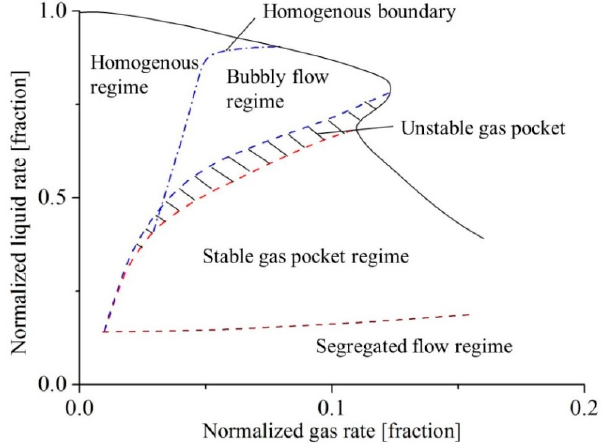
Figure 1. Example of two-phase mapping proposed by Estevam et al. [17] and Barrios [18] for ESP pumps. Pump head coefficient ratio ψ * tp = ψ tp / ψ 0 , is defined as the actual two-phase head coefficient ψ tp divided by the head coefficient ψ 0 obtained for liquid single